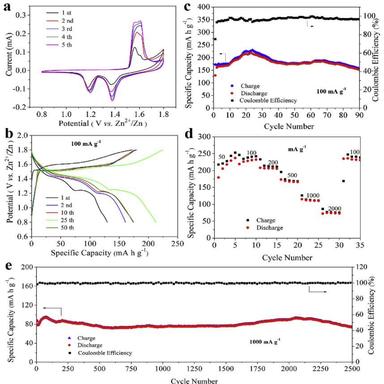
Electrochemical performances of ZnMn2O4/NG cathode. (a) CV curves at a scan rate of 0.1 mV s−1 , (b) charge/discharge curves at different cycles at 100 mA g−1 , (c) cycle performance at 100 mA g−1 , (d) rate performance at a series of current densities, and (e) prolonged cycling performance at 1000 mA g−1 .